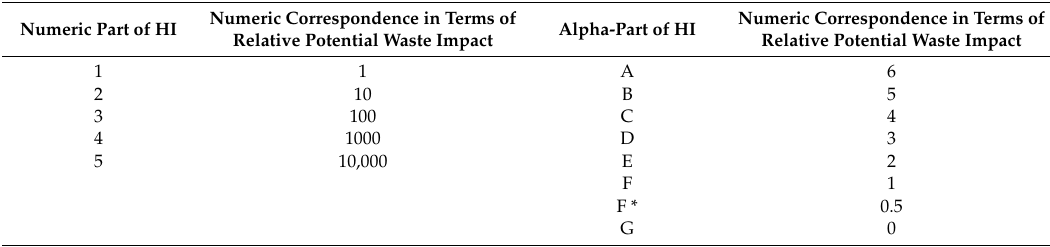
Table 2. Conversion table from alpha-numeric score to the corresponding Hazard Risk Level (HRL).